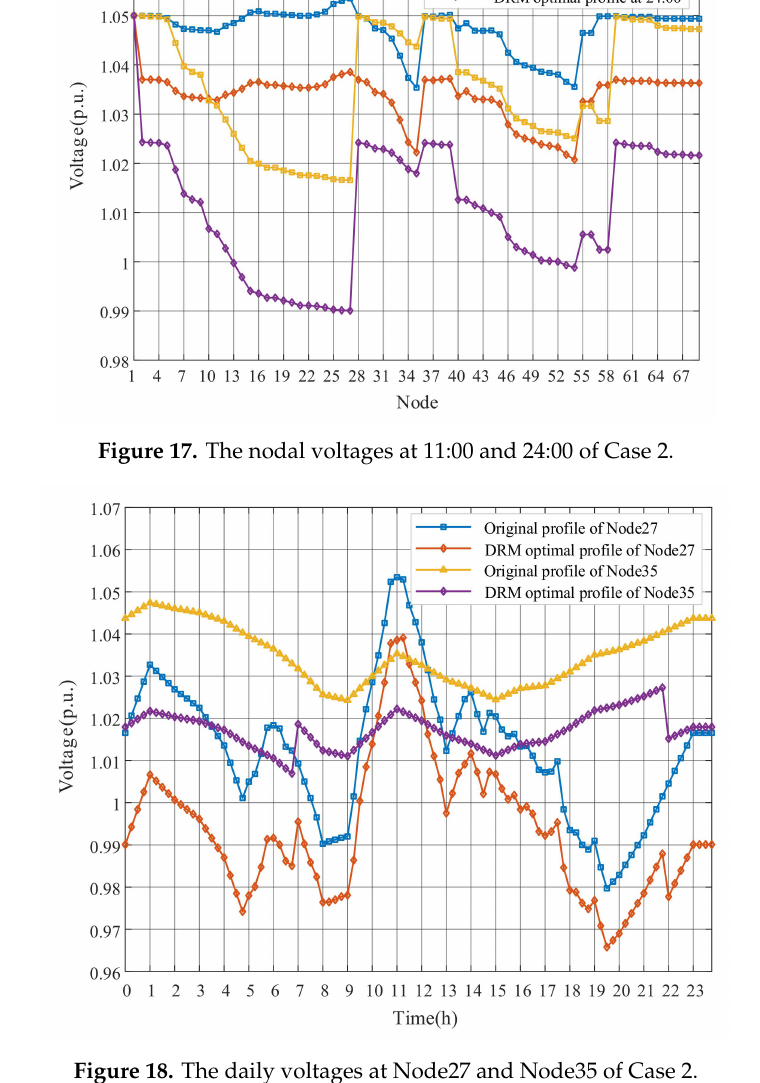
Figure 18. The daily voltages at Node27 and Node35 of Case